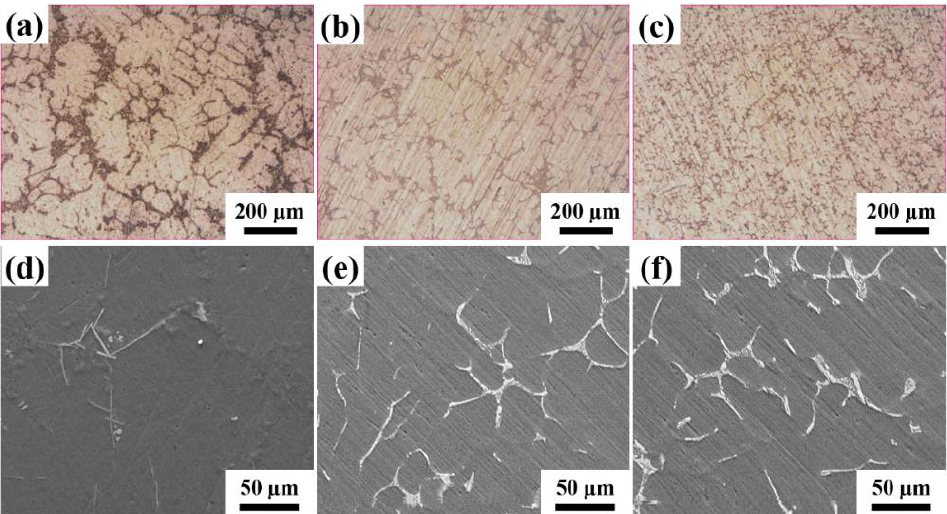
Figure 2. ( a – c ) Optical micrographs and ( d – f ) scanning electron microscopy images of the cast samples fabricated by ( a , d ) GDC route, ( b , e ) LPSC route, and ( c , f ) HPSC route, respectively.